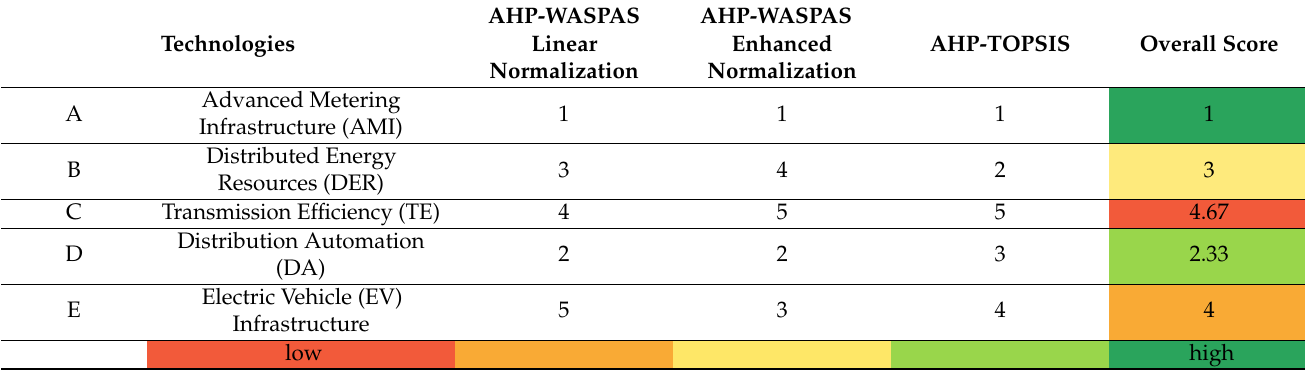
Table 23. The overall